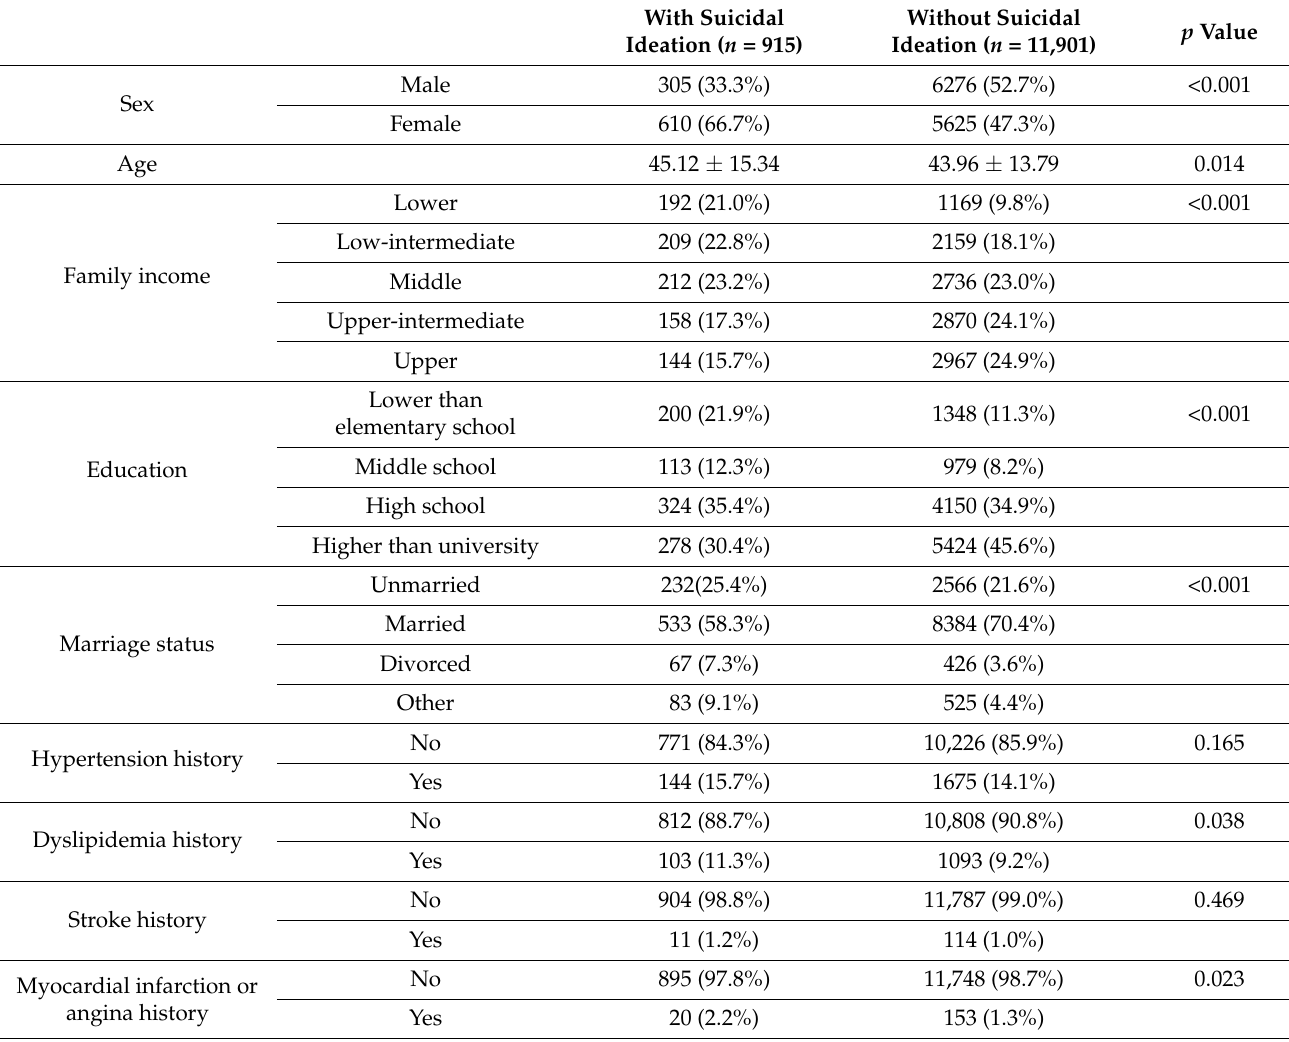
Table 1. General characteristics of subjects according to suicidal ideation and work